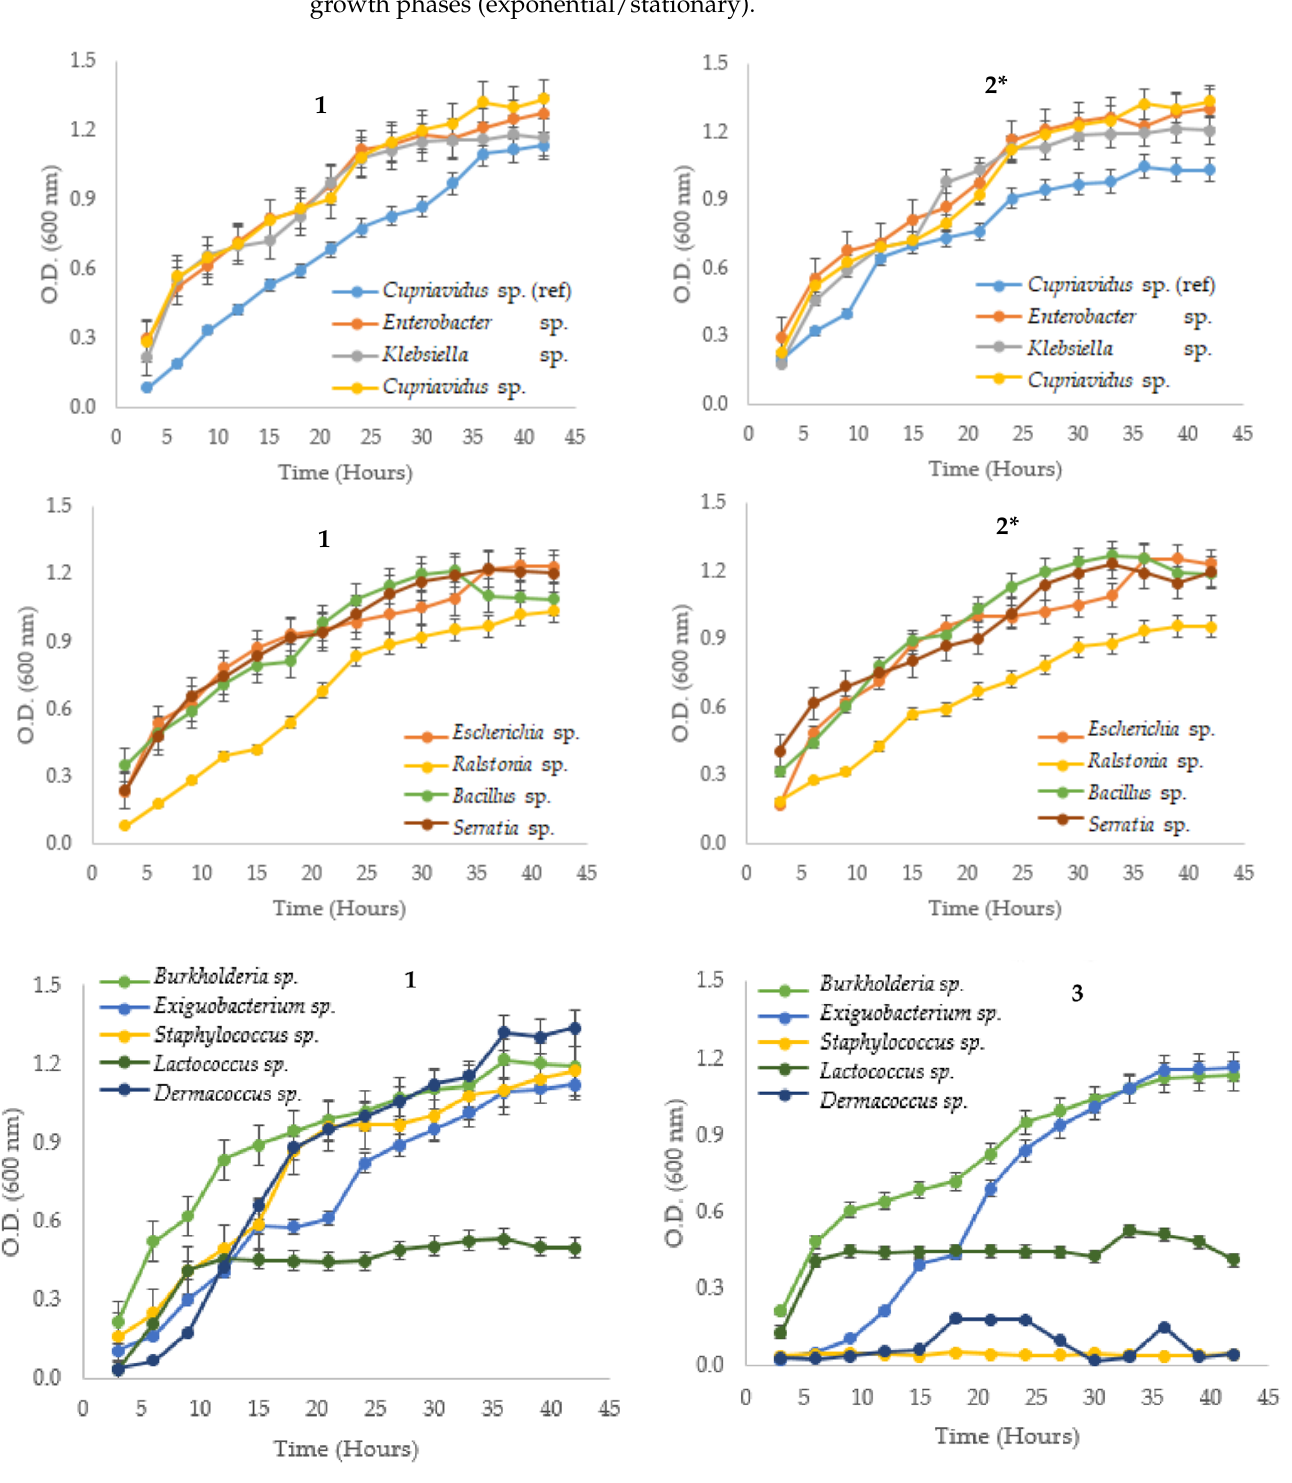
Figure 1. Growth curve native bacteria strains; 1 : 0 mg Cd/L, 2 : 15 mg Cd/L, 3 : 10 mg Cd/L. * Strains grow in both Cd concentrations with the growth curve at the highest concentration.